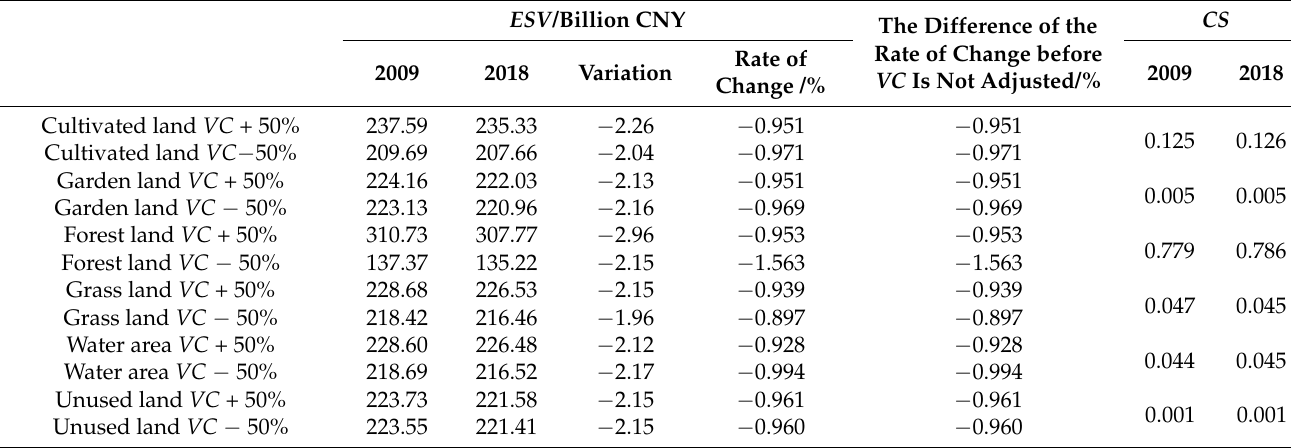
Table 5. Estimation of the coefficient of sensitivity and ecosystem services value after the adjustment of the total ecosystem services value coefficient in Guizhou